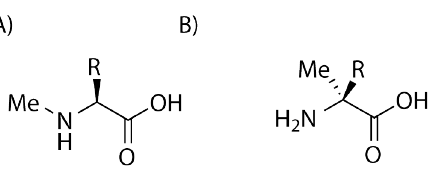
Figure 2. Example of methylation of the N-terminus ( A ) and of the α -carbon ( B ).